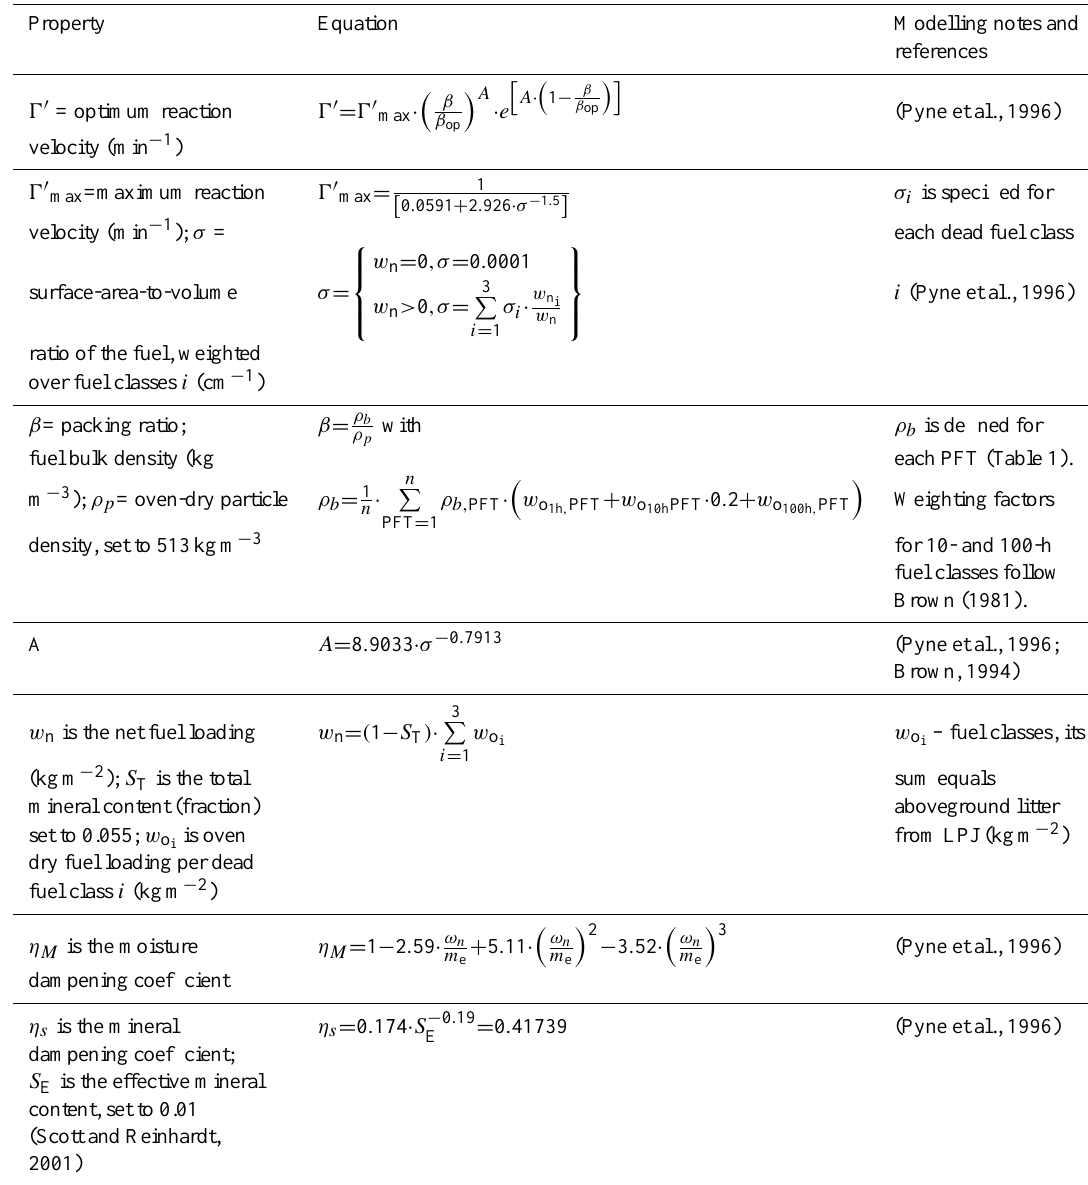
Table A1. Additional equations and variables of the fire spread model. Property